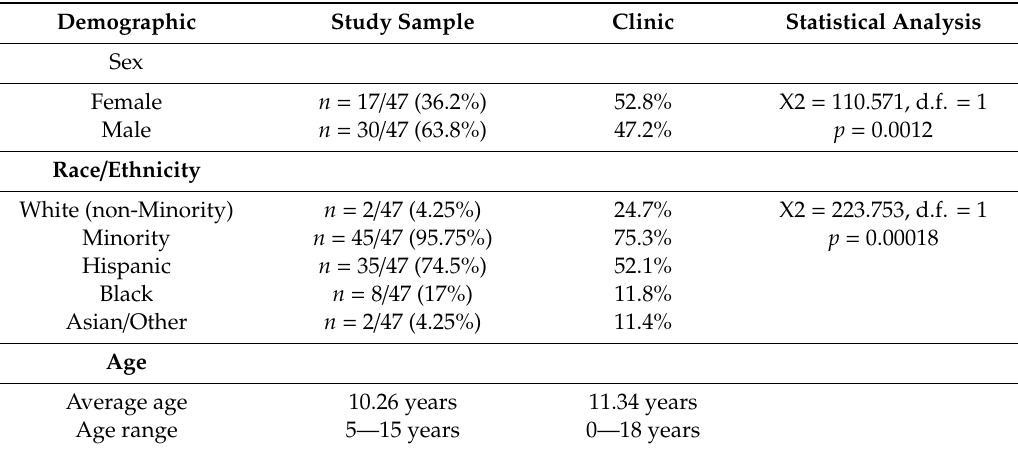
Table 2. Demographic analysis of study